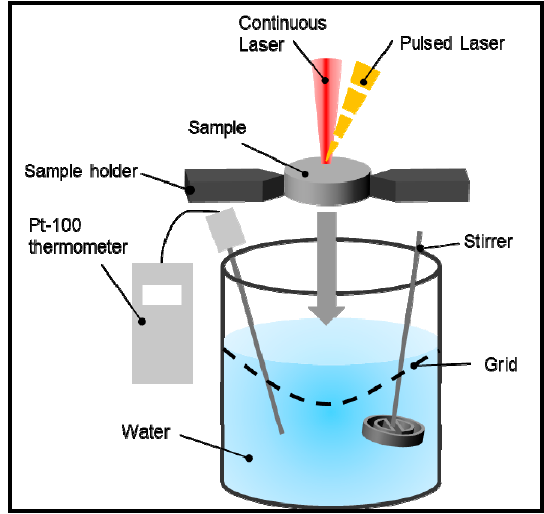
Figure 2. Schematic of the test stand for absorption measurements.